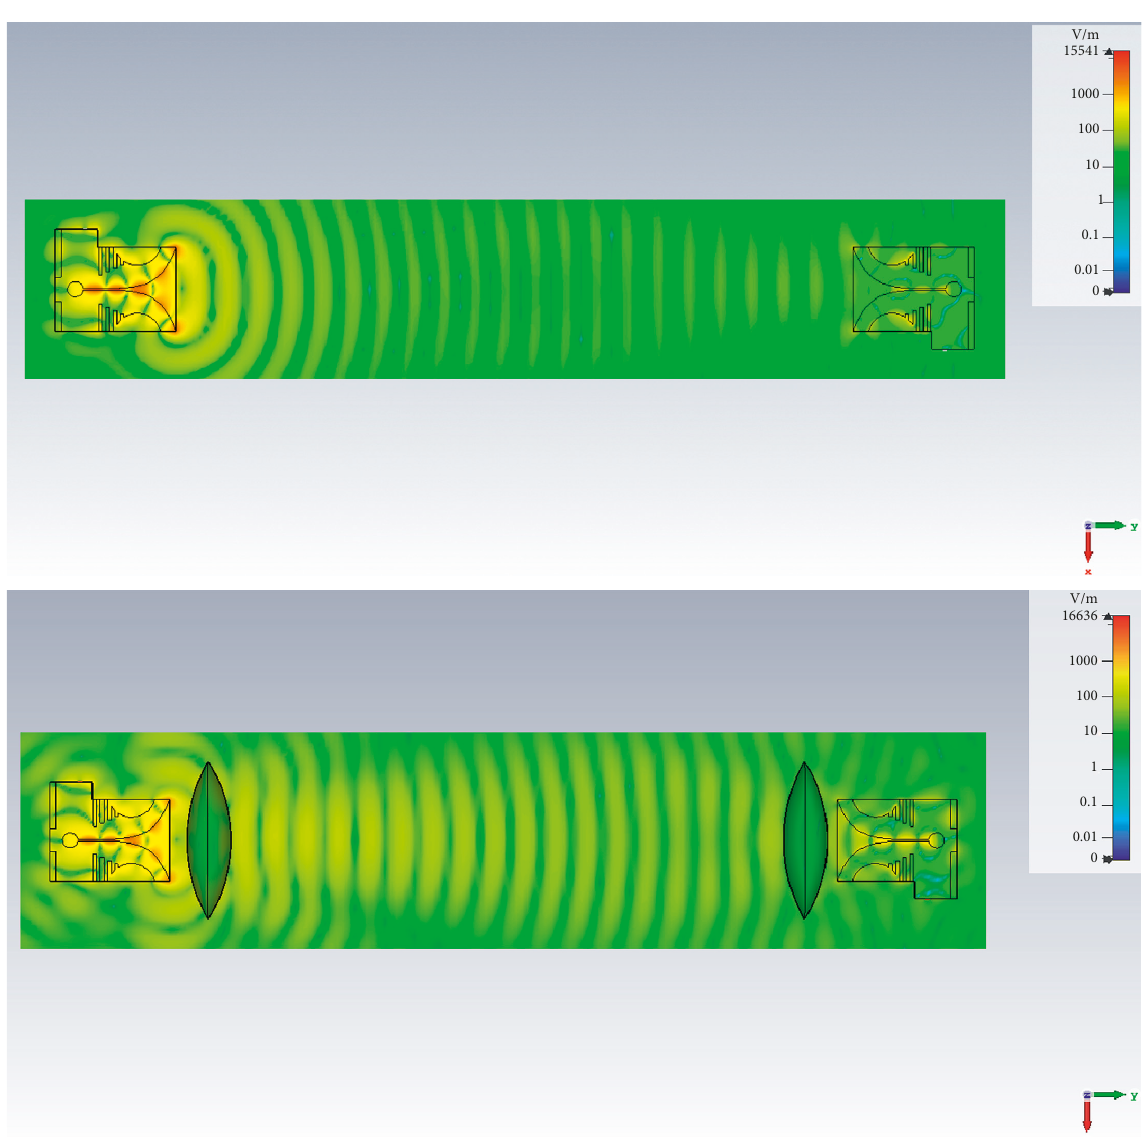
Figure 13: Transceiver system consisting of two Vivaldi antennas without and with dielectric lenses. The field maps concerning the transverse x - and y -components of the electric field were obtained by full-wave numerical simulations at 5.8